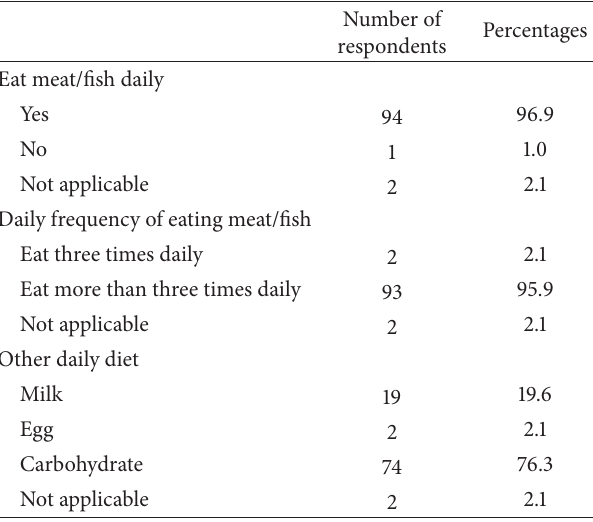
Table 4: Summary of nutrient intake of the preschool aged children